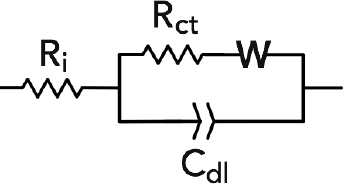
Figure 7. Equivalent circuit used to fit the impedance spectra. Table 10. Thickness, resistance, specific conductivity, and charge transfer resistance values obtained by electrochemical impedance spectroscopy for samples containing various PAN:PCL ratios. The results obtained for a glass fiber sample are also reported.